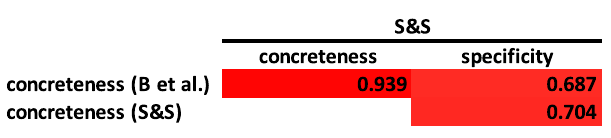
FIGURE 14 | Spearman’s ρ correlations between the Spreen and Schulz (1966) and Brysbaert et al. (2014) ratings for the subset of 226 nouns in the intersection.